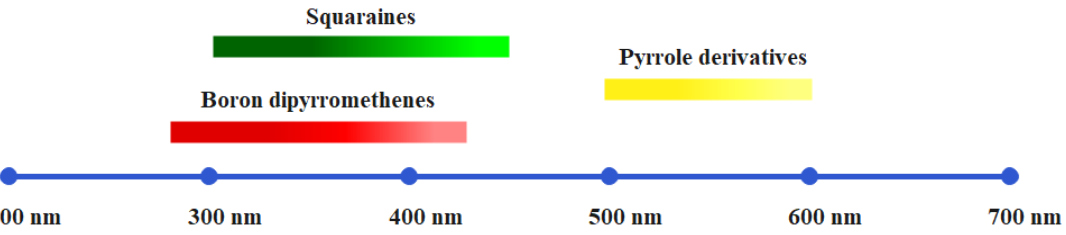
Figure 13. Absorption ranges of novel sensitizers. The squaraines (SQM1-SQM3) absorb in the range from 300 nm to 450 nm. These compounds show activity in ultraviolet and visible light regions. On the other hand, the systems containing one of pyrrole derivatives (PSQ1, PSQ2, BPSQ1 or BPSQ2) are suitable for initiating the radical polymerization of various monomers in visible light. The absorption spectrum extend from 500 nm to 600 nm. The photoinitiators based on boron dipyrromethenes (BODIPYs 1–8) work under UV-Vis light. The absorption bands of BODIPYs 2–8 extend from 280 nm to ca. 410 nm and from 280 nm to 480 nm for BODIPY-1. The